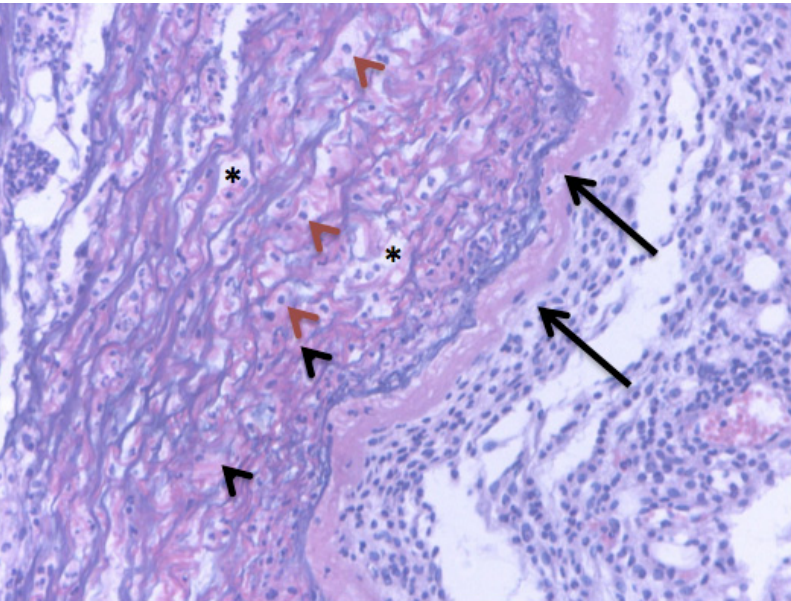
FIGURE 1 - Photomicrography of week 1 of the experiment. PPM presented a dense and compact region (black arrows) and an area of free fibers (tip of black arrow) permeated by intense inflammatory infiltrate, mainly mononuclear (tip of blue arrow) with areas of edema (asterisk). HE stains. Zoom: 40x. PPM: porcine peritoneum